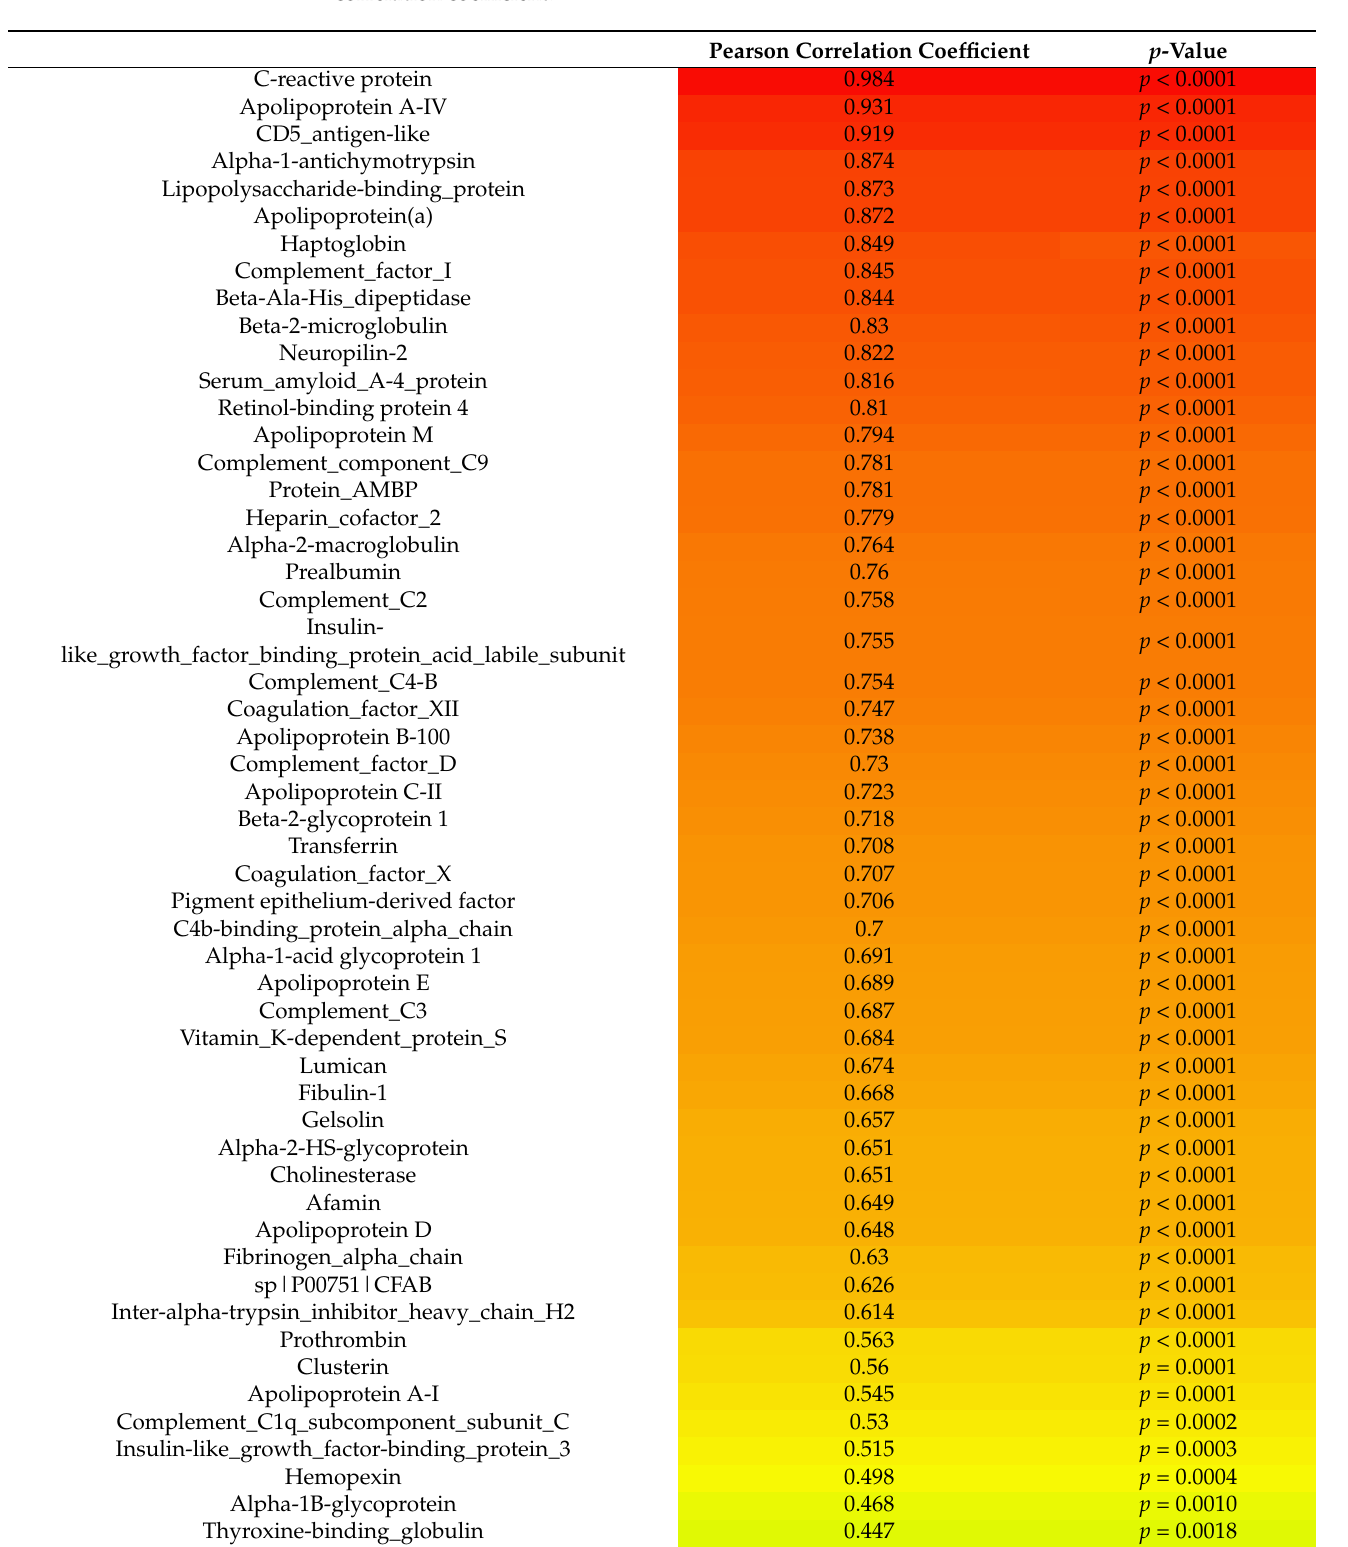
Table 2. Protein correlation of plasma microsampling and DBS. Significant p -value are underly- ing. Red color indicated a high Pearson correlation coefficient and a green color a low Pearson correlation